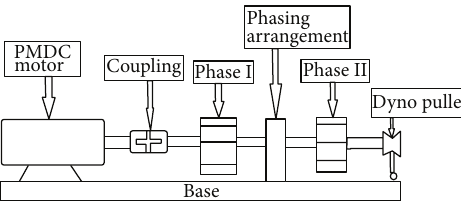
Figure 1: Schematic layout of test set-up for measurement of planetary gear set noise.